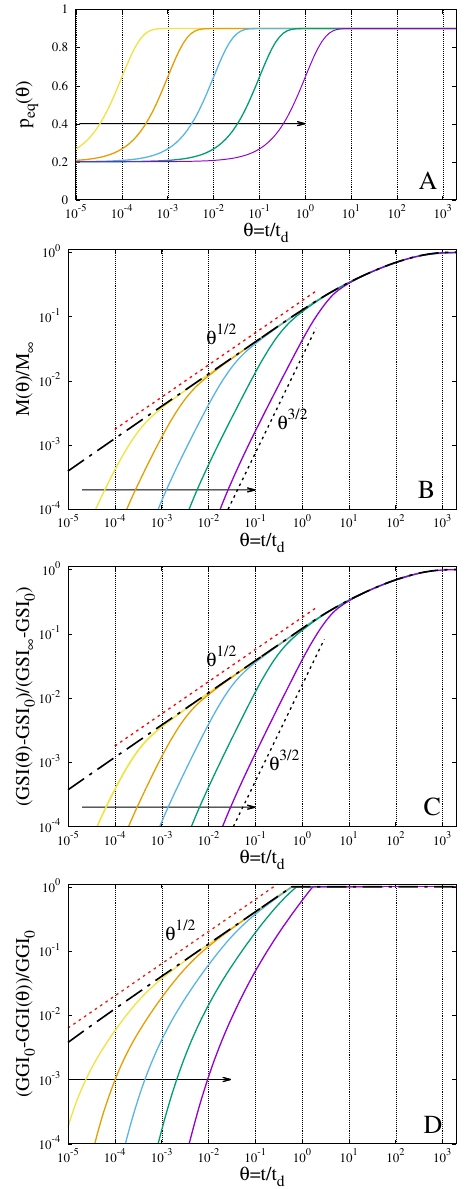
Figure 3. Temporal evolution of the boundary solvent volume fraction p eq ( θ ) ( A ), the normalized amount of absorbed solvent ( B ), the rescaled Gel–Solvent interface ( C ) and the rescaled Glass–Gel interface ( D ). Arrows indicate increasing values of De = 10 − 4 ,10 − 3 ,10 − 2 ,10 − 1 ,10 0 . Dot-dashed black lines represent the behaviour of the parabolic transport scheme, representing the limiting case De →